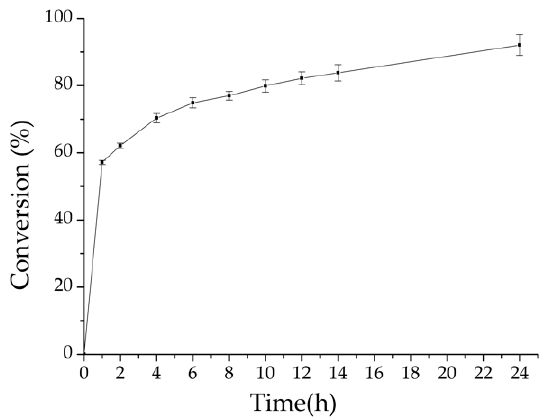
Figure 3. Reaction time course of M6P with polyphosphate-dependent mannose kinase, mannose (20 g/L), (NaPO 3 ) 6 (60 g/L), and MgCl 2 (5 mM) at 30 °C at pH 8.5. The reaction rate was very fast in the first hour, then slowly decreased, and the conversion efficiency reached 92.09% at 24 h.